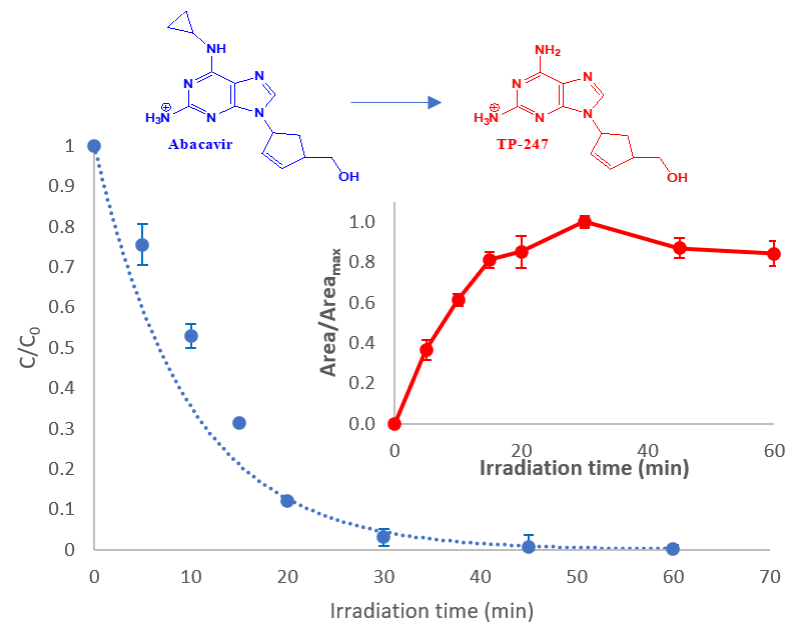
Figure 1. Degradation of abacavir. Inset: evolution profile of the most abundant TP (TP-247). C 0 = 10 mg/L, CTiO 2 = 10 mg/L, matrix = ultrapure water.